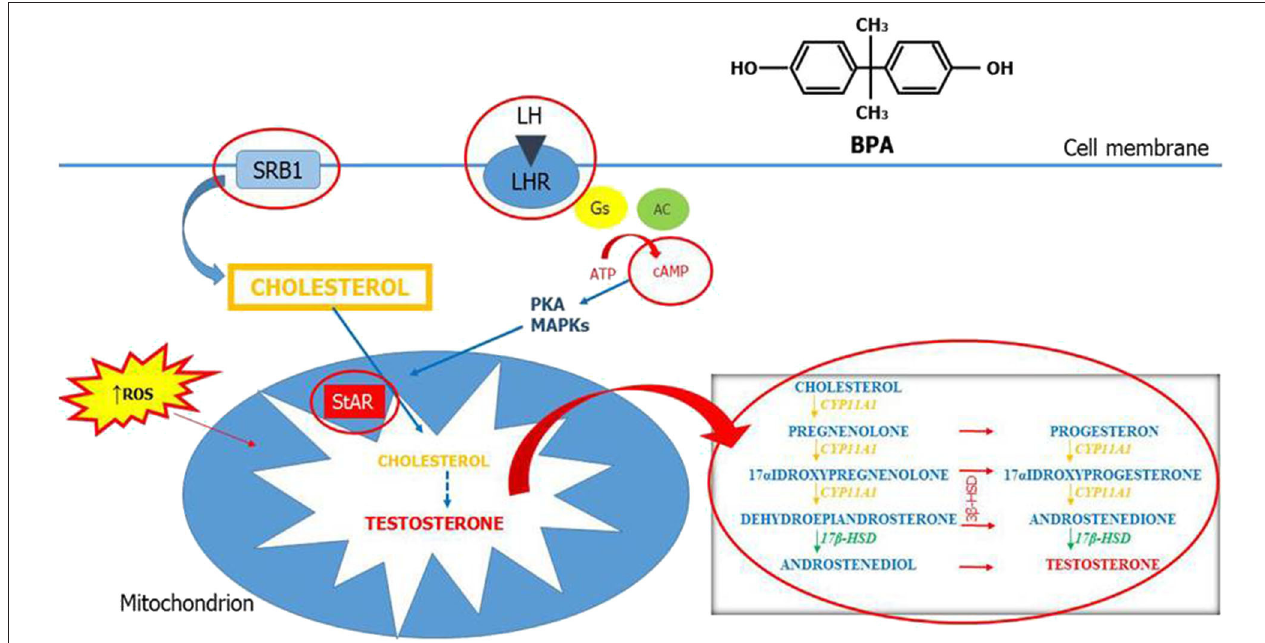
FIGURE 2 | Mechanisms of action of bisphenol A on testicular steroidogenesis. Testicular steroidogenesis is a complex and fine-regulated process that bisphenol A (BPA) can perturb by acting with several mechanisms represented in this figure (circled in red).